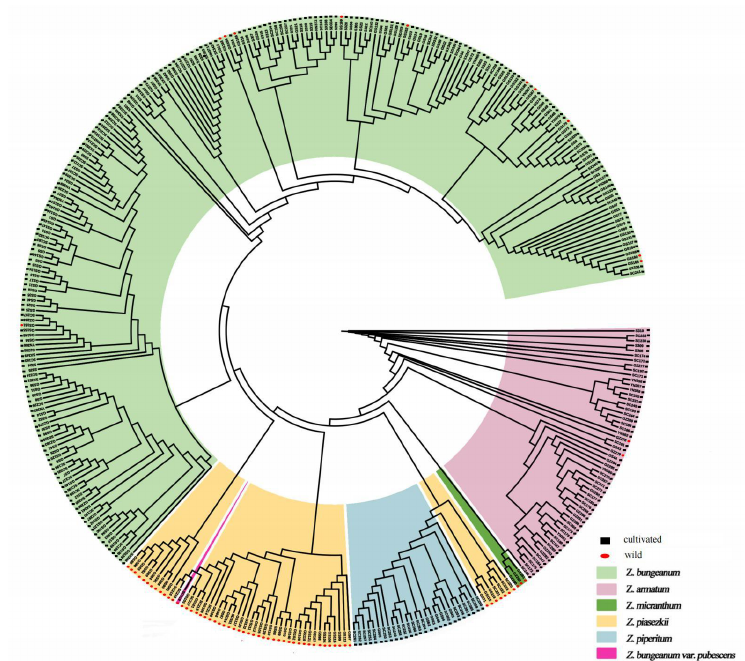
Figure 3. Neighbor-joining (NJ) tree of 373 wild and cultivated Zanthoxylum accessions based on the cpDNA